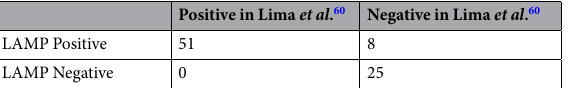
Table 3. Performance of Mo2 LAMP on previously characterized M . ozzardi patient